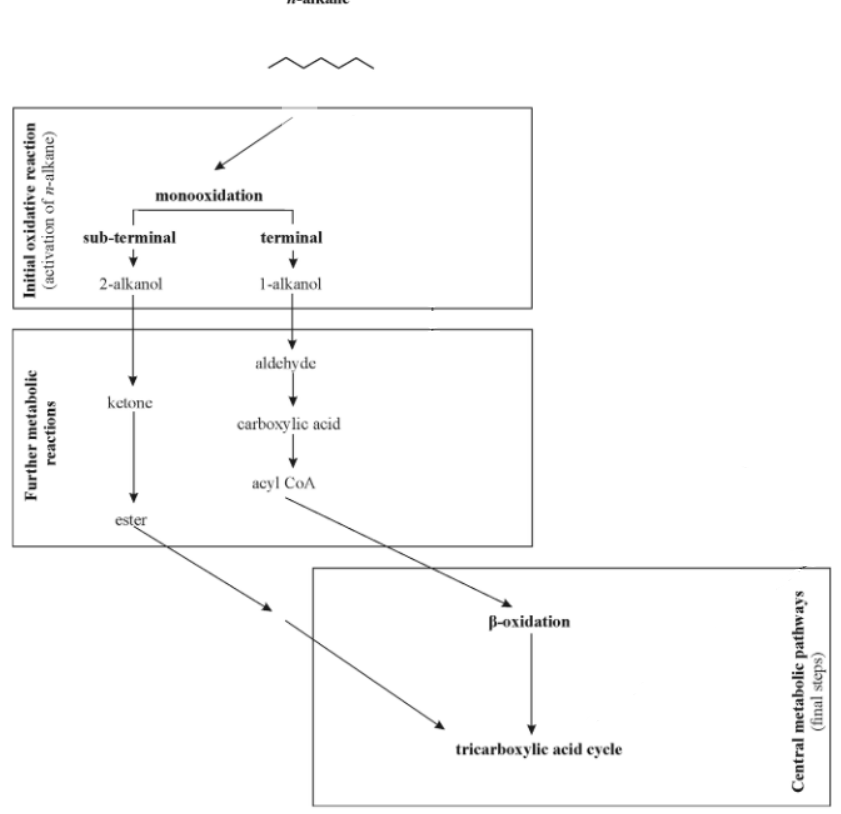
Figure 1. Biodegradation pathways of alkanes by aerobic bacteria “modified figure from